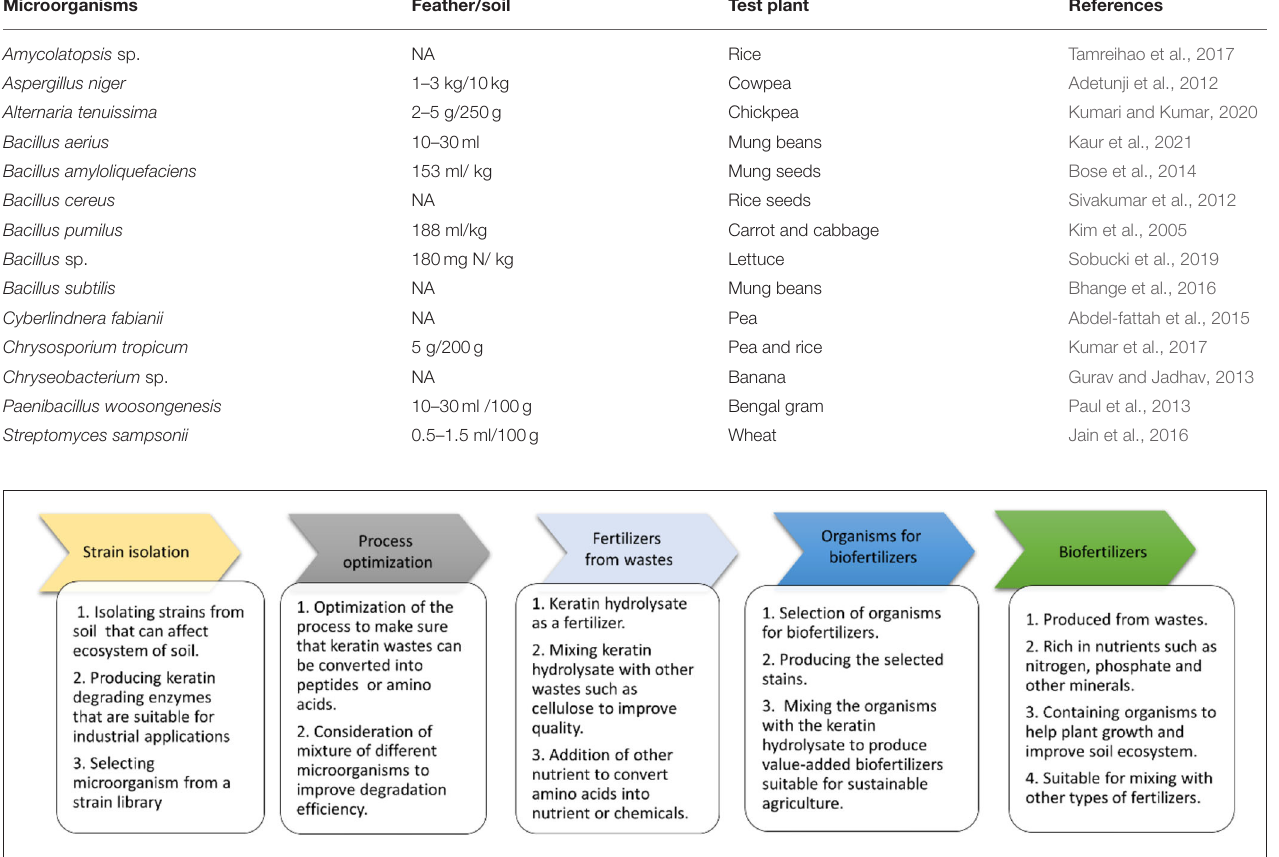
TABLE 2 | Some examples of microbial feather hydrolysate as fertilizer to promote plant growth. Microorganisms